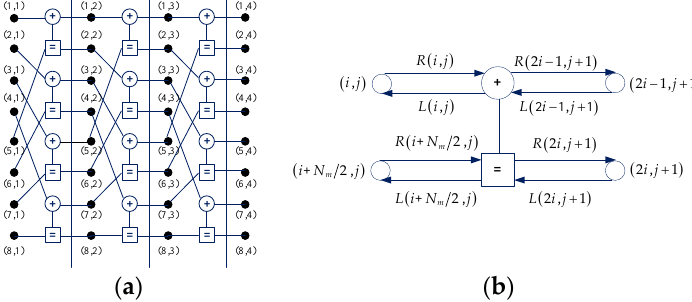
Figure 7. Factor graph and processing element. ( a ) Factor graph; ( b ) processing element. The left messages and right messages are passed toward the left and right direction of the factor graph, respectively. The L ( i , n + 1 ) and R ( i , 1 ) are respectively initialized by the prior LLR information z v , k and